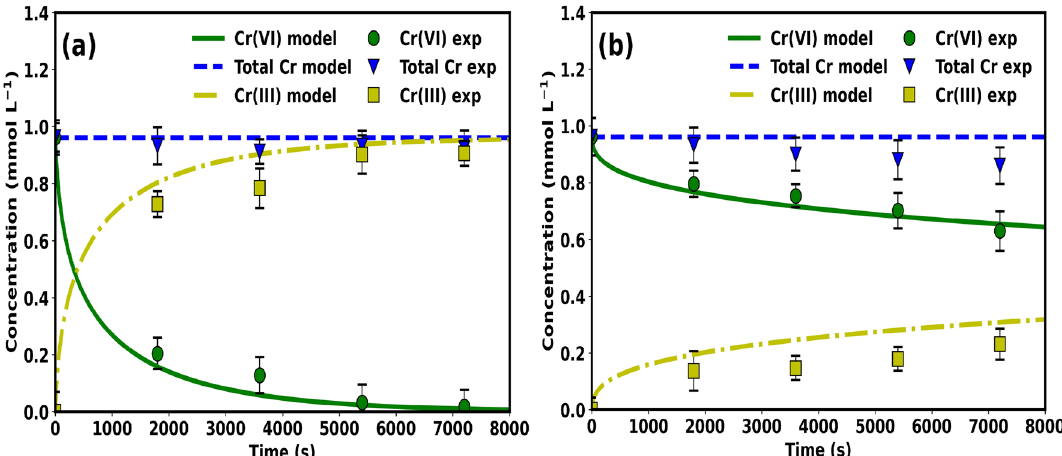
Figure 10. Reduction of Cr(VI) and product formation of Cr(III) when using ( a ) Bio-PdNPs and ( b ) Chem-